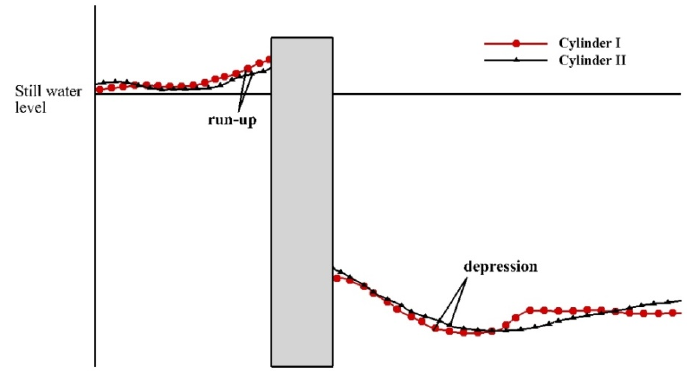
Figure 6. The schematic of the water level for G/D = 1.0 and T/D = 1.50.